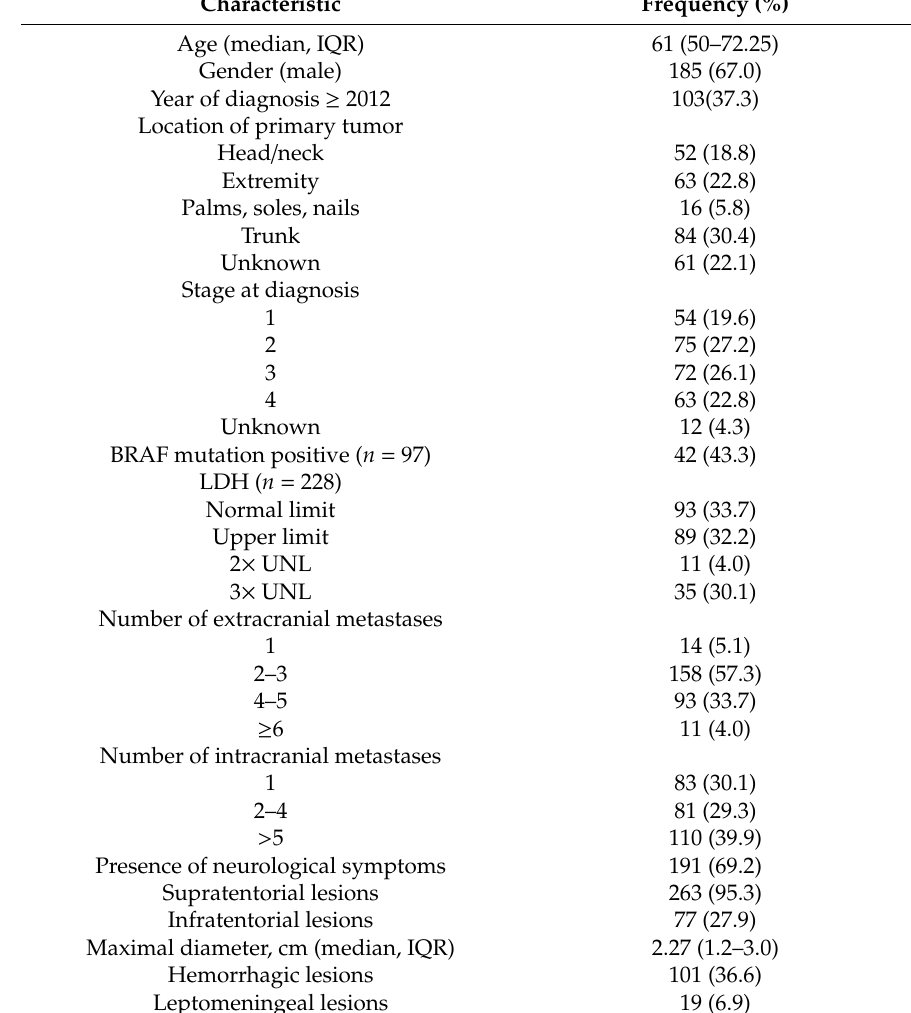
Table 1. Demographics and clinical characteristics of the 276 patients